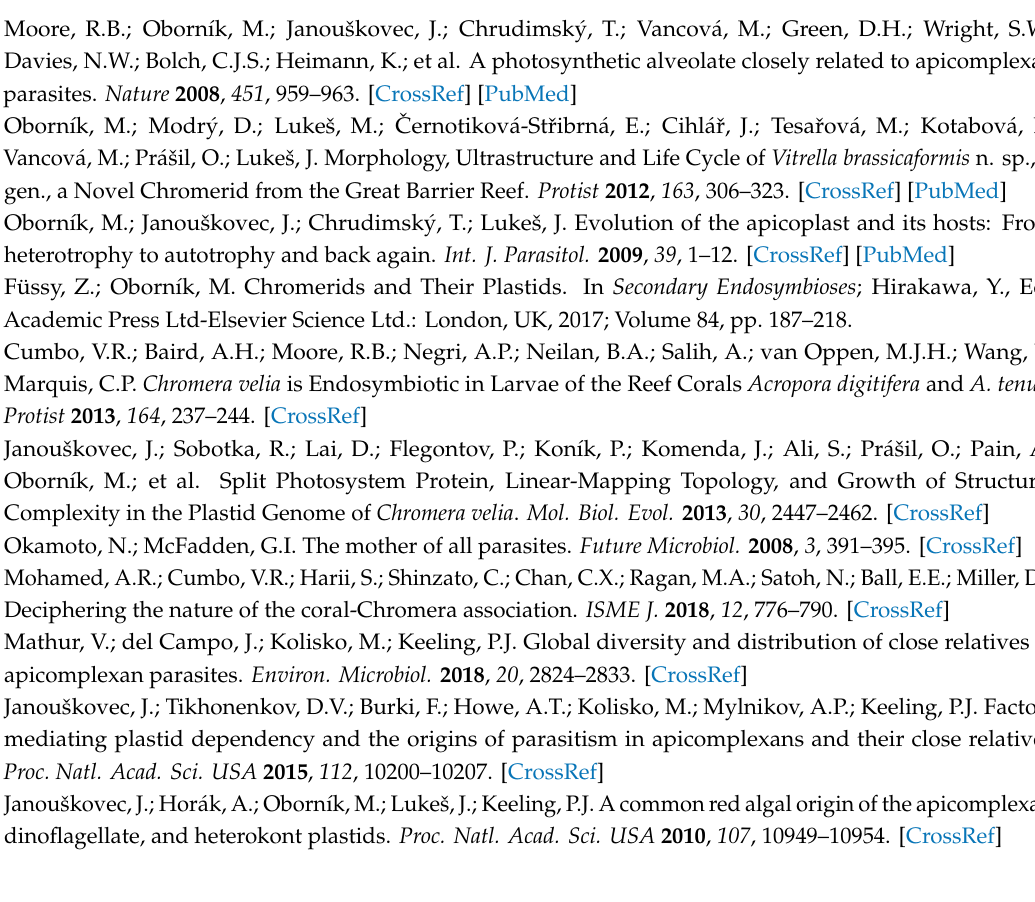
s1: Figure S1. The ∆ -9 desaturases Likelihood / Bayesian tree. Figure S2. The ∆ 5 / 6 (front-end) desaturase Likelihood / Bayesian tree. Figure S3. The omega ( ∆ 12 / 15) desaturase Likelihood / Bayesian tree. Figure S4. The model of fatty acid biosynthesis in Chromera velia (A) and in Vitrella brassicaformis (B). Figure S5. Growing curves of Chromera velia treated by the various concentration of triclosan recorded by the Tecan instrument ( n = 5). Figure S6. Spectra of fatty acid composition changes after triclosan treatment obtained by GC / FID. Figure S7 Transmission electron microscopy of C. velia grown in standard f / 2 medium (A) and grown in f / 2 medium with 333 µ M triclosan (B), where the cell is deformed and the inner structure is collapsed. LD—lipid droplets; N—nucleus; P—plastid. Figure S8. The ratio of fatty acids shorter than C18 and C18 (blue) and longer than C18 (orange) in C.velia during nitrogen deprivation and repletion ( n = 5). Figure S9. Maximum-likelihood phylogenetic tree of acetyl-CoA decarboxylases. Figure S10. The alignment of ACCases of chromerids, showing the first 408 amino acid residues, with the N-terminal motif similarity shared between plastid-targeted gene